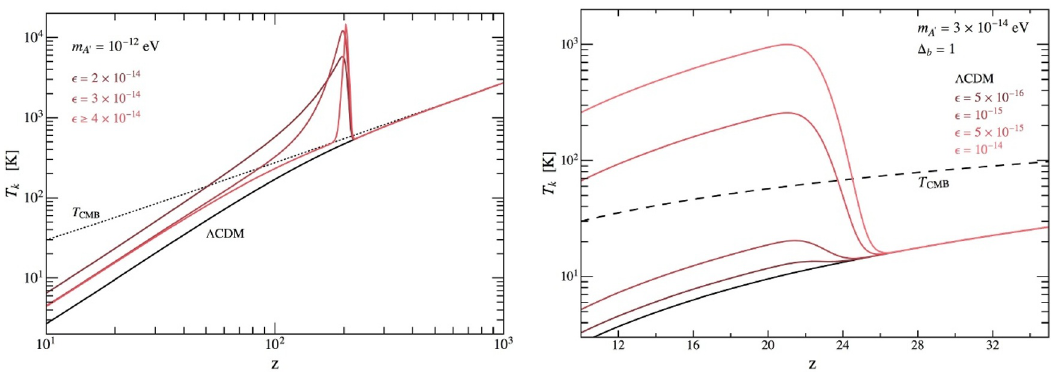
Figure 5 . Left: evolution of matter temperature T k assuming homogeneous energy injection at high z (modeled using Gaussian with a width (cid:1) z = 5). Right: evolution of matter temperature at low redshift, assuming (cid:1) b = 1, for m A 0 = 3 (cid:2) 10 (cid:0) 14 eV and various values of (cid:15) .